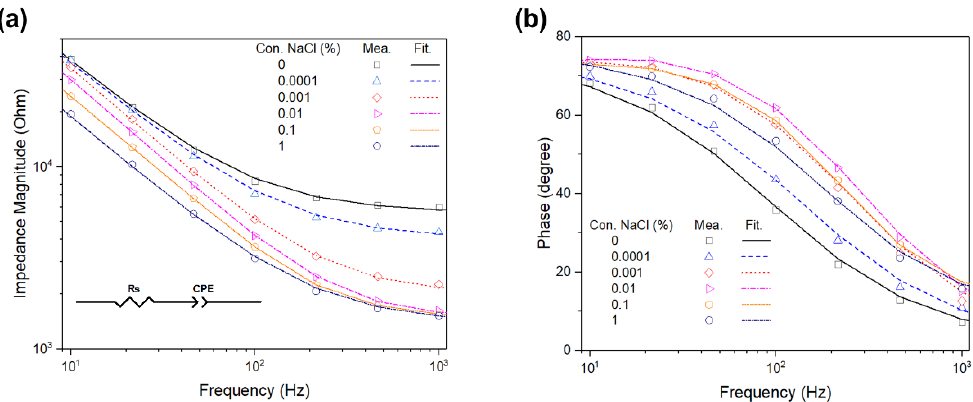
Figure 2. Electrical impedance spectra ( a , b ) of the IWE measured in different concentrations of NaCl electrolyte. The data points represent the measured (mea.) impedance spectra. The dotted lines represent the impedance spectra fitted (Fit.) using an equivalent circuit model, consisting of the solution resistance (R s ), and a double-layer capacitance (CPE).